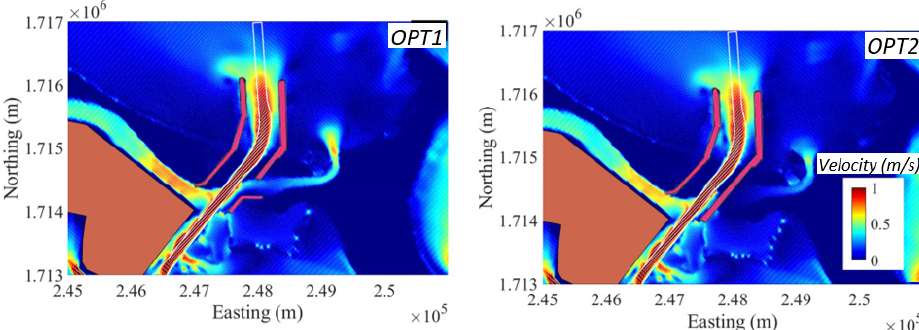
Figure 18. Current field during the Northeast monsoon after jetty construction.